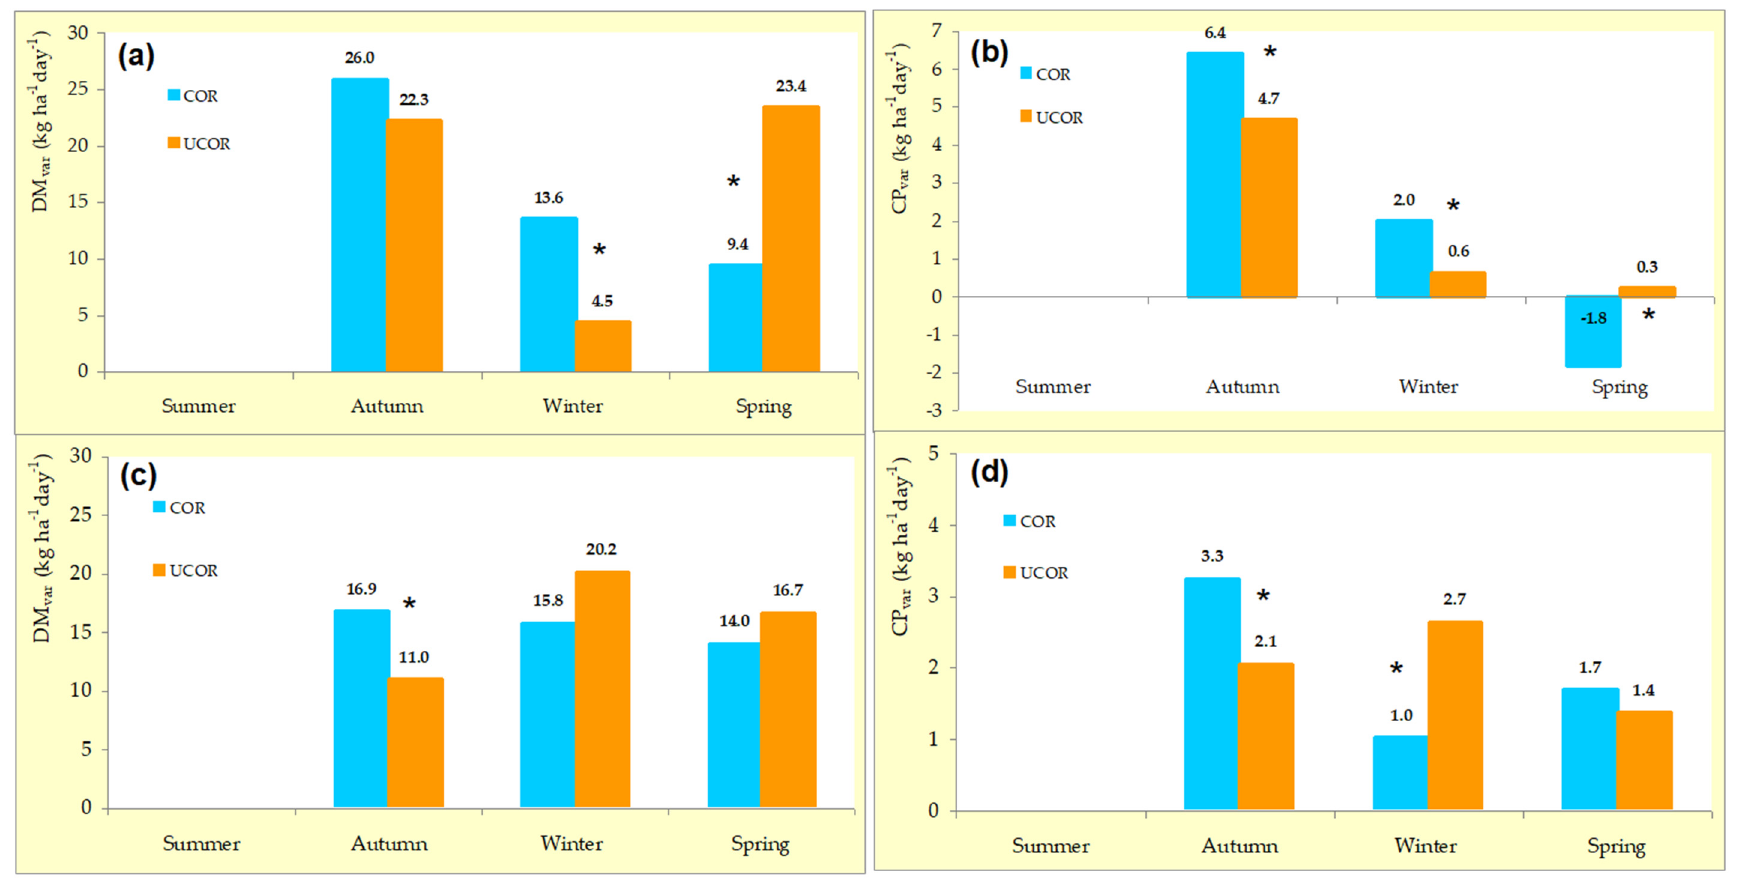
Figure 5. Pasture daily growth rate (kg·ha − 1·day − 1) in amended areas (COR) and unamended areas (UCOR), in the vegetative cycles of 2018/2019 (( a , b ), respectively dry matter, DMvar and crude protein, CPvar) and 2019/2020 (( c , d ), respectively dry matter, DMvar and crude protein, CPvar). * Significant at the 0.05 level.